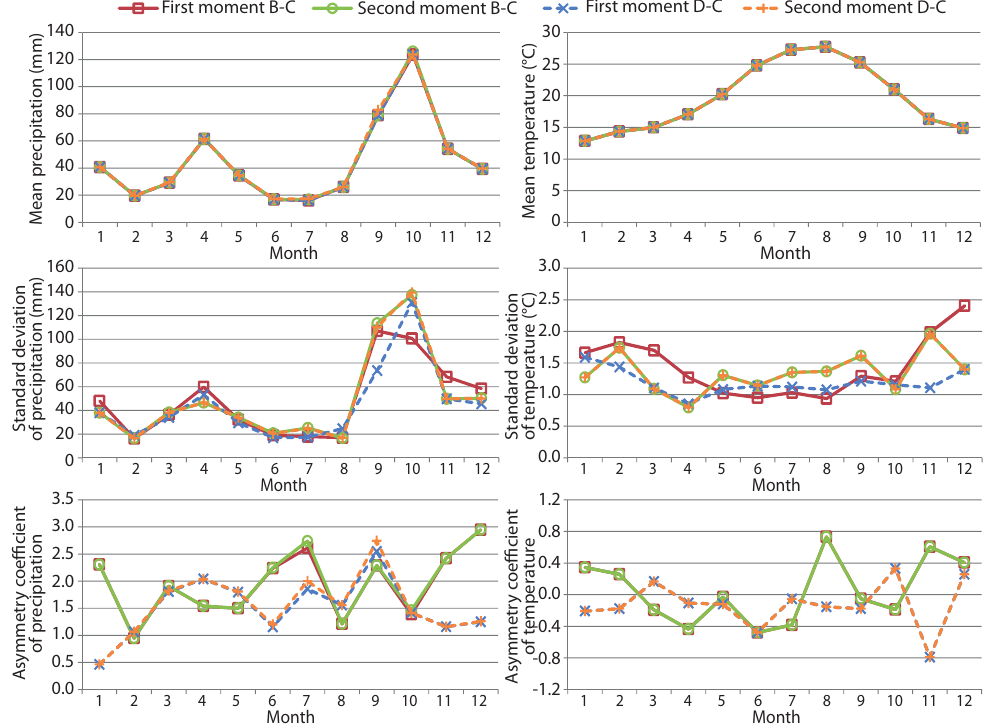
Figure 8. Mean, standard deviation and asymmetry coefficients of future precipitation series (A) and future temperature series (B) for the average year for the RCM RCA4 model linked to the CNRM-CM5 GCM.